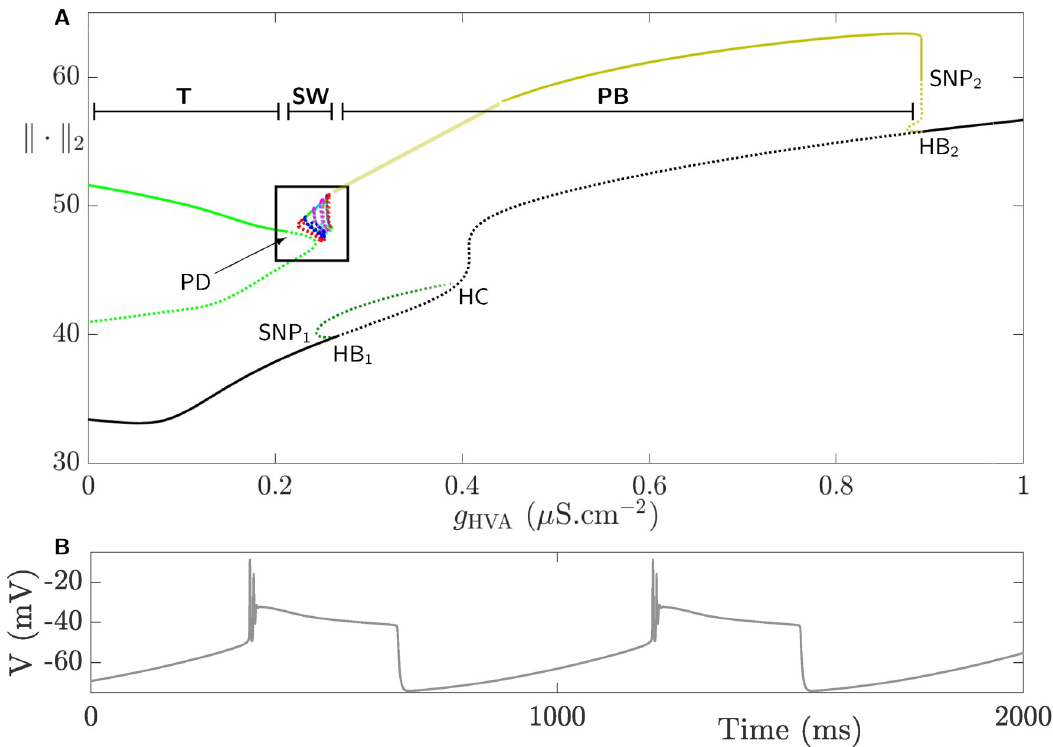
Fig 5. The effects of g HVA on the dynamics of the full system (1). A ) Bifurcation diagram of the full system (1) with respect to g HVA using the L 2 -norm of the state variables. The branch of equilibria (black) undergoes two Hopf bifurcations, labeled HB 1 and HB 2 . The equilibria are unstable (dotted) between HB 1 and HB 2 and stable (solid) otherwise. The envelope of unstable periodic orbits (dotted dark green) emanating from HB 1 undergoes a saddle-node bifurcation of periodic orbits ( SNP ) and terminates at a homoclinic bifurcation, denoted HC . The envelope of periodic orbits (dark olive) generated from HB 2 is unstable, but becomes stable at a saddle-node bifurcation of periodic orbits ( SNP ) and terminates at a homoclinic bifurcation very close to the right of HB 1 (not shown). The light olive line is the continuation of the dark olive line obtained by numerical integration of the full system (1). Both correspond to the envelope of pseudo-plateau BPOs (labeled PB ). The � -shaped curve (light green) is an isola of POs corresponding to tonic firing (labeled T ); it consists of two branches separated by a saddle-node bifurcation of periodic orbits ( SNP 1 ). The upper branch is stable and becomes unstable at a period-doubling bifurcation ( PD ). The set of (colorful) curves to the right of PD within the box shows a family of more isolas of square-wave BPOs (labeled SW ) (for better visualization, see the magnification of this box in Fig 6 A ). B ) Time course of a pseudo-plateau BPO for g HVA = 0.4 μ S.cm − 2